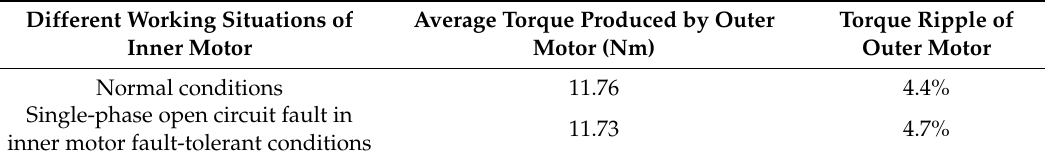
Table 9. The torque (Nm) produced by outer motor under different conditions.